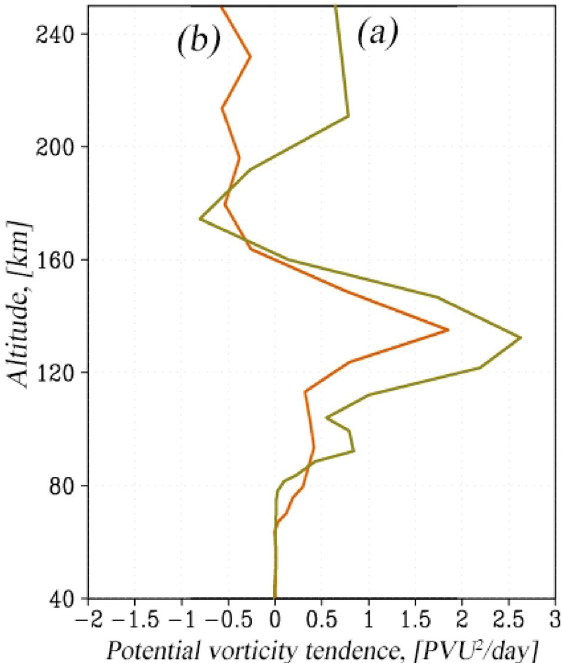
Figure 5. Vertical profile of the sum of all terms in the perturbed potential enstrophy balance equation for non-migrating diurnal tide (averaged over latitudes and longitudes, PVU 2 /day)—(a). Sum of terms describing nonlinear interaction between SPW1 and migrating diurnal